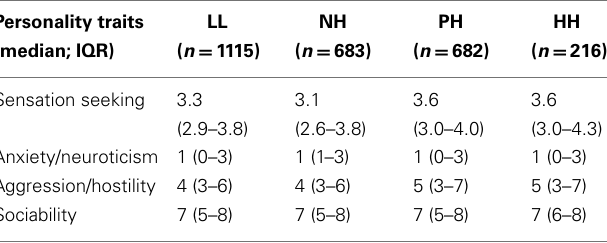
Table 3 | Personality traits of the four drinking profiles a by drinking location .